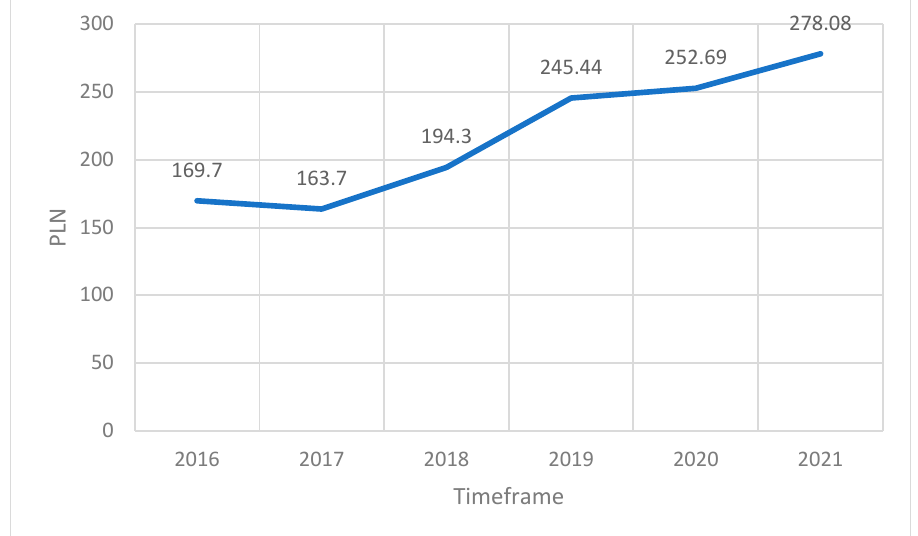
Figure 4. Annual increase of the selling price of electricity (PLN/MWh). Source: author’s own compilation based on collective annual information from the President of the Energy Regulatory Office on the selling price of electricity on the competitive market.